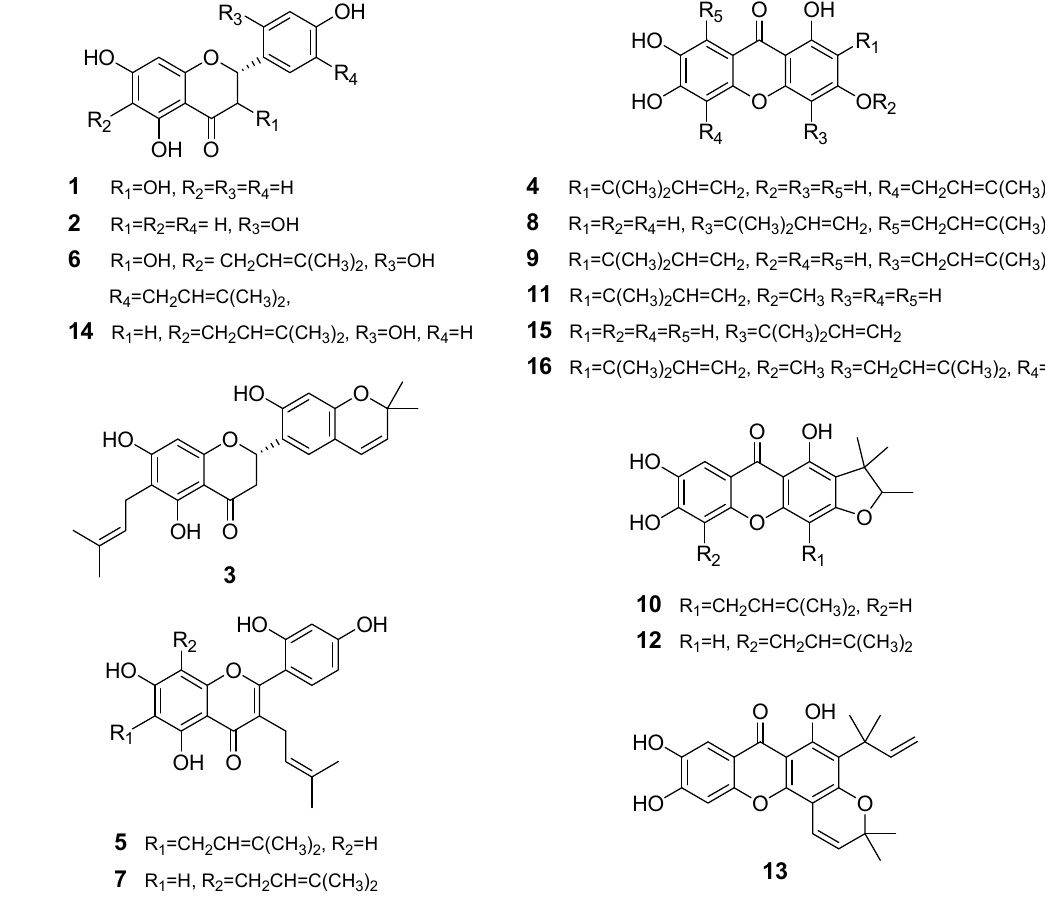
Figure 1. Chemical structures of the sixteen C. tricuspidata compounds used in this study. 2.2. E ff ects of the Sixteen C. tricuspidata Compounds on HO-1 Protein Expression and Nuclear Translocation of Nrf2 in HT22, RAW264.7, and BV2 Cells To investigate whether any of these compounds induced the expression of HO-1 HT22, RAW264.7, and BV2 cells were treated with the indicated concentrations of each of the test compounds for 12 h and then assayed by Western blotting. Cobalt protoporphyrin (CoPP), an established HO-1 inducer, was used as a positive control. CTC 2 , 3 , 4 , 7 , 9 , 10 , and 12 significantly induced HO-1 expression in HT22 cells (Figure 2), whereas 3 , 7 , 9 , 14 , and 15 induced HO-1 expression in RAW264.7 cells (Figure 3) and CTC 1 , 2 , 3 , 7 , 9 , 10 , 11 , 12 , 13 , 14 , and 15 . HO-1 expression in BV2 cells (Figure 4). CTC 3 and 7 were able to induce significant HO-1 expression in all three cell lines, with CTC 7 exhibiting the strongest induction. Thus, we examined the e ff ect of CTC 7 treatment on the nuclear translocation of activated Nrf2. For this purpose, HT22, RAW264.7, and BV2 cells were treated with 40 µ M CTC 7 for 0.5, 1, and 1.5 h, and Nrf2 expression was assayed using Western blotting. This assay showed that CTC 7 treatment induced the nuclear translocation of Nrf2 in a time-dependent manner (Figure